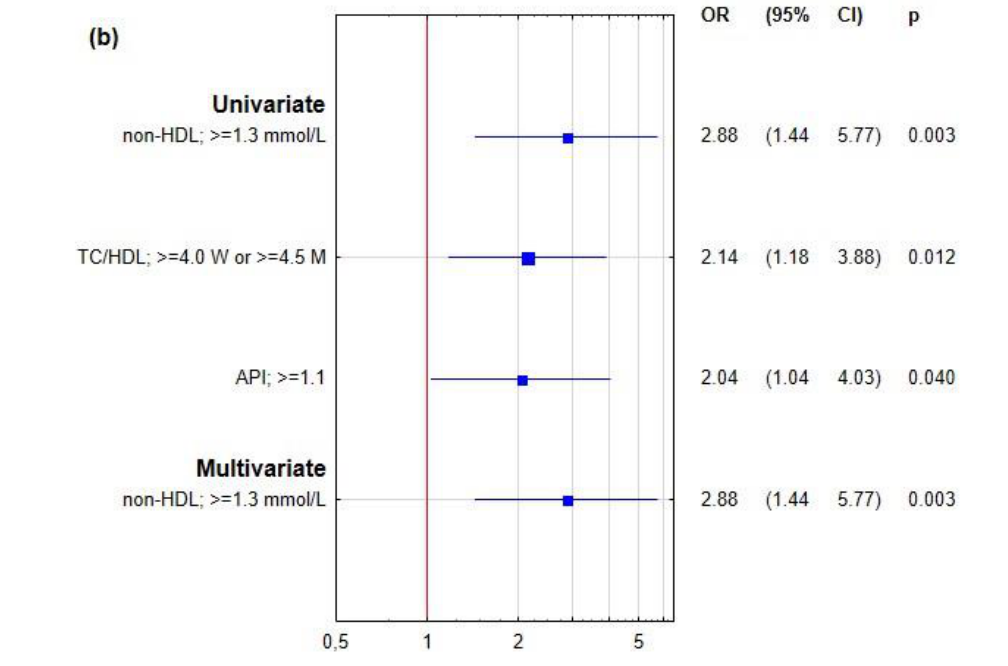
Figure 1. Univariate and multivariate analysis of logistic regression was performed for the Upper Quartile of sdLDL in age groups <35 years (Panel a ) and ≥ 35 years (Panel b ). The multivariable model included sex, non-HDL-C, TC/HDL, and API, provided as dichotomous variables divided according to the criteria described in the Material and Methods section. Variables selection was conducted by the forward stepwise procedure. Non-HDL—non-high-density lipoprotein cholesterol; API—atherogenic plasma index; RC—regression coefficient; OR—odds ratio; CI—confidence interval; W—women; M—men. A p -value < 0.05 was considered significant.